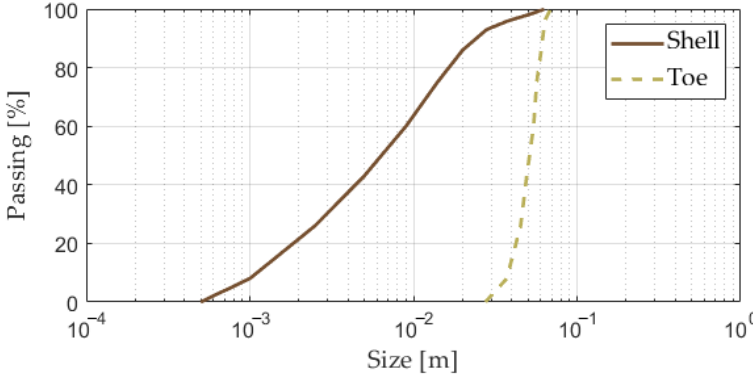
Figure 6. Gradation curve shown for shell and toe